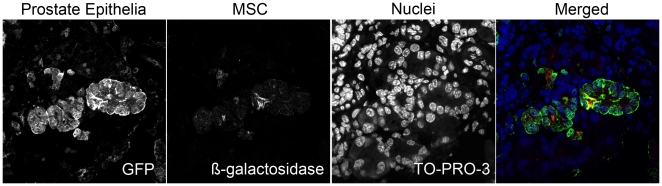
MSCs fused to the prostate during regrowth.β-galactosidase-expressing MSCs were injected into castrated GFP mice supplemented with exogenous testosterone for three days. Confocal microscopy showed colocalization of β-galactosidase-expressing MSCs (red) with GFP prostate ducts (green). Nuclei were stained with TO-PRO-3 (blue). Merged color panel illustrates colocalization of MSCs (red) with prostate epithelia (green), indicated by yellow. Fusion occurred in 48.9% of recruited MSCs.